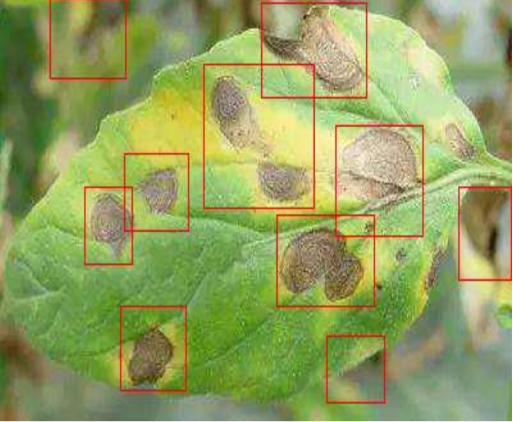
Figure 4. Detection effect of buckwheat ring rot disease.